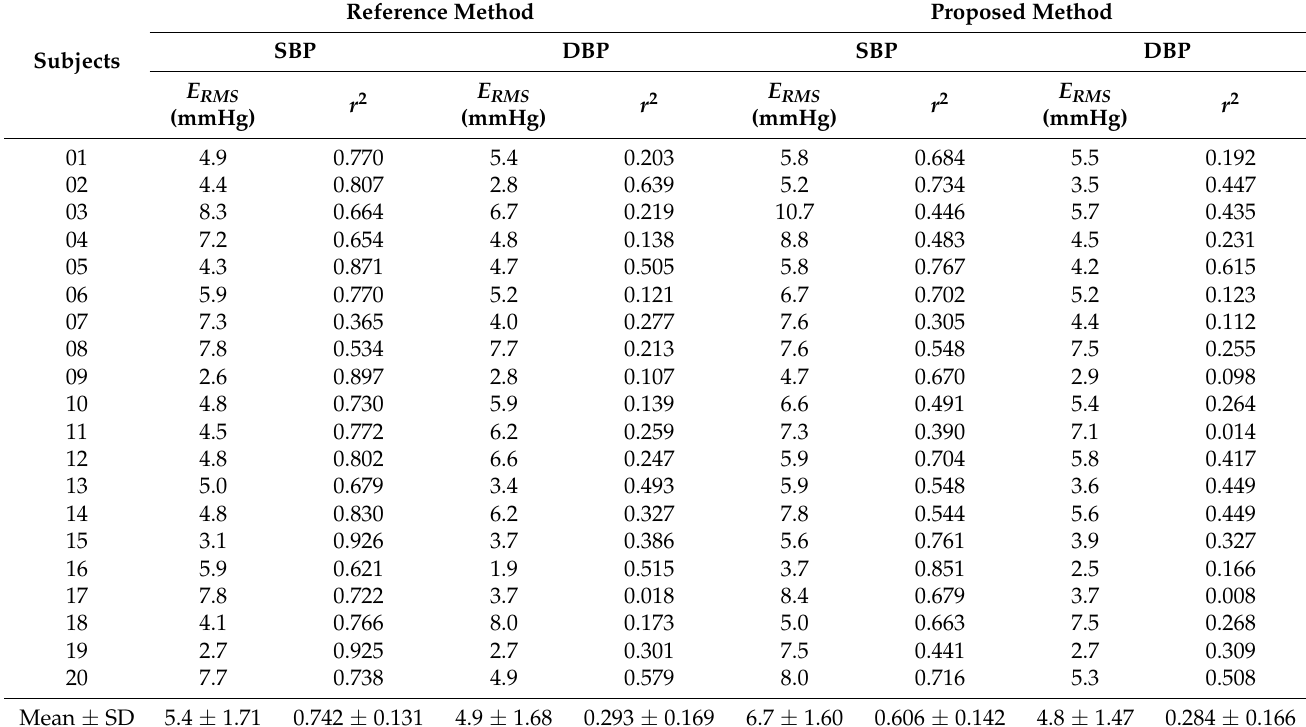
Table 5. The results of estimated systolic and diastolic blood pressures with Equation (4).